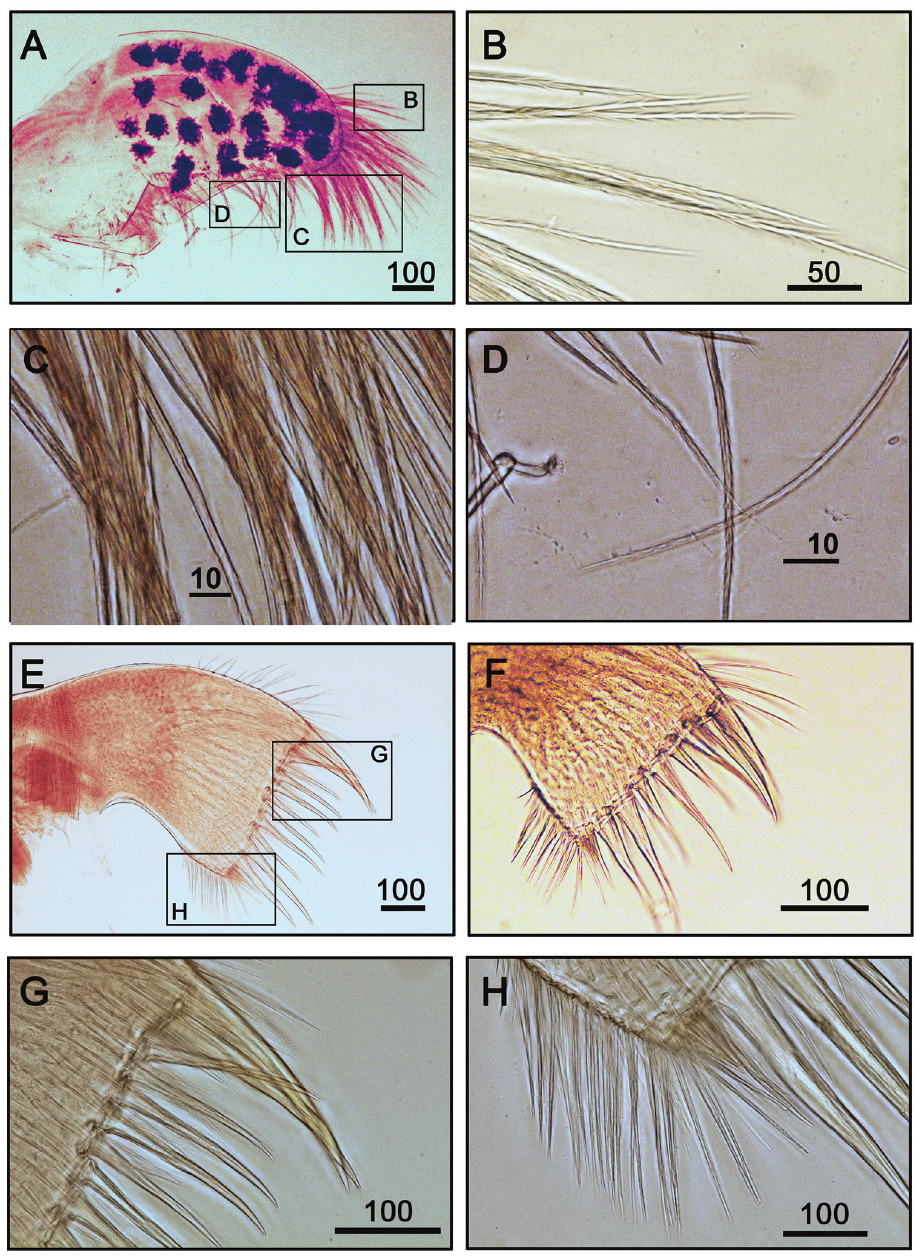
Figure 4. Maxilla and maxillule of Galkinius maculosus sp. n. A Maxilla oval, with dark spots (ASIZCR000343) B–D Serrated setae on margin E Maxillule (ASIZCR000343) F Maxillule (CEL-DSA-012-6) G Large sim- ple setae on straight cutting edge H Simple setae on lateral margin. Scale bars in